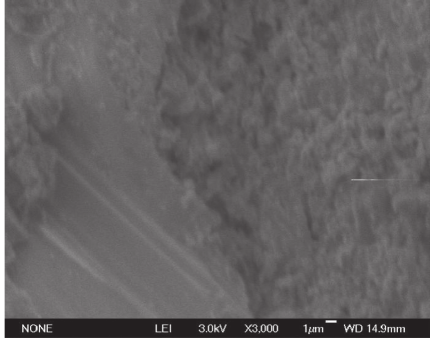
Figure 4: Sectional topography of 20G after deposition